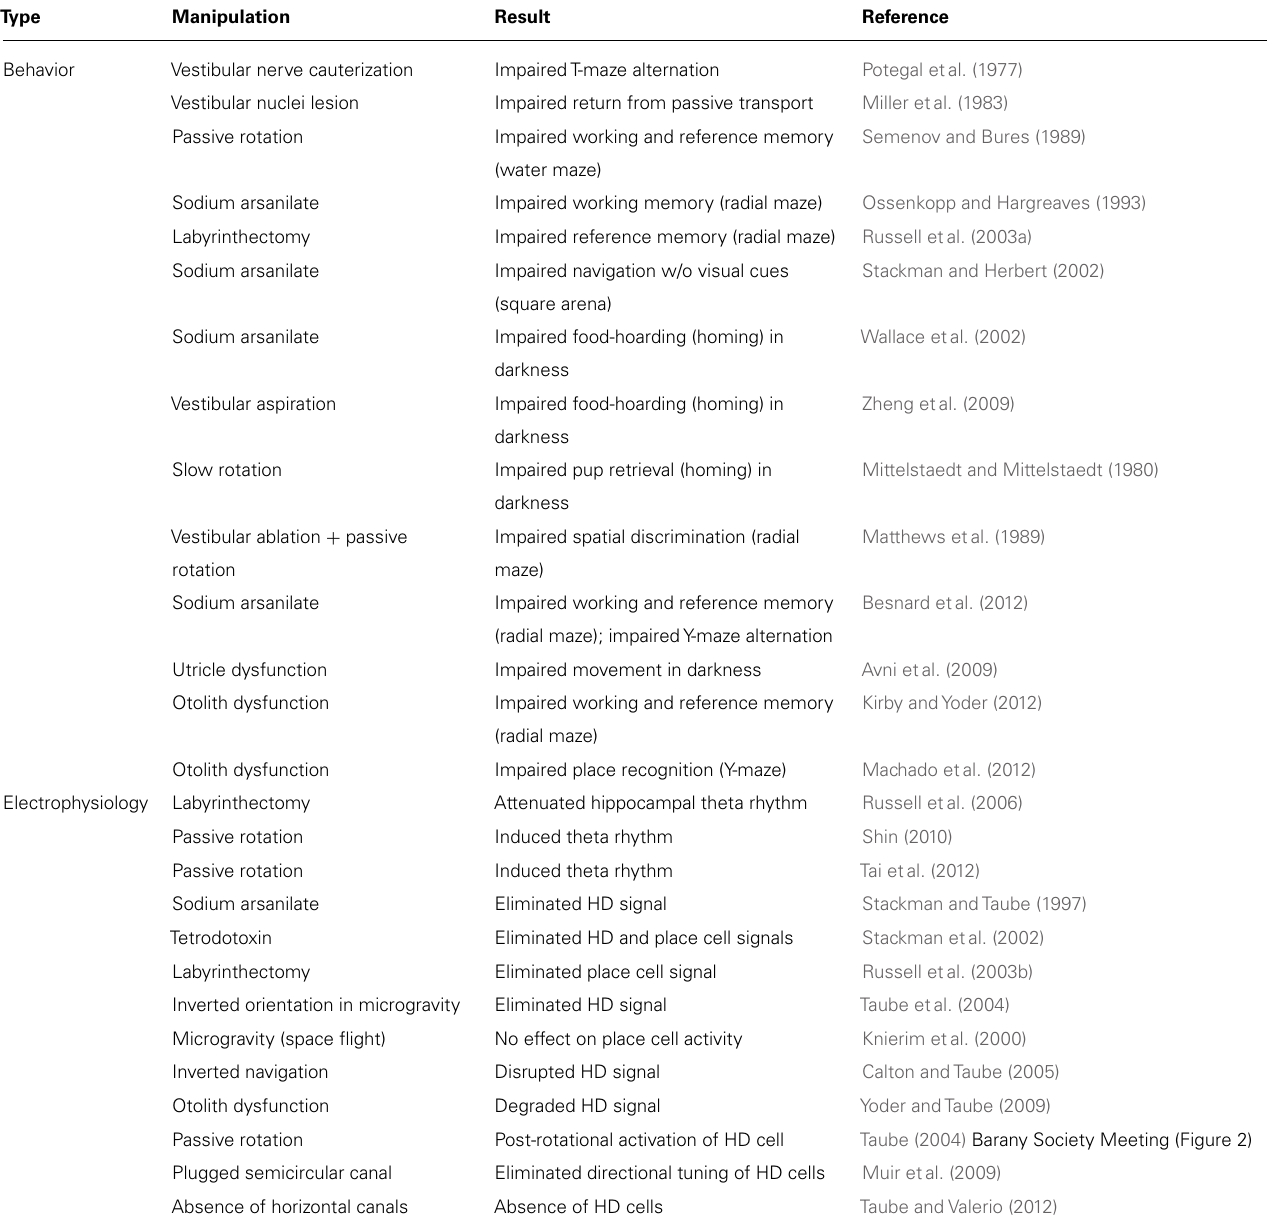
Table 1 | Effects of vestibular system manipulations on navigation and spatial signals in